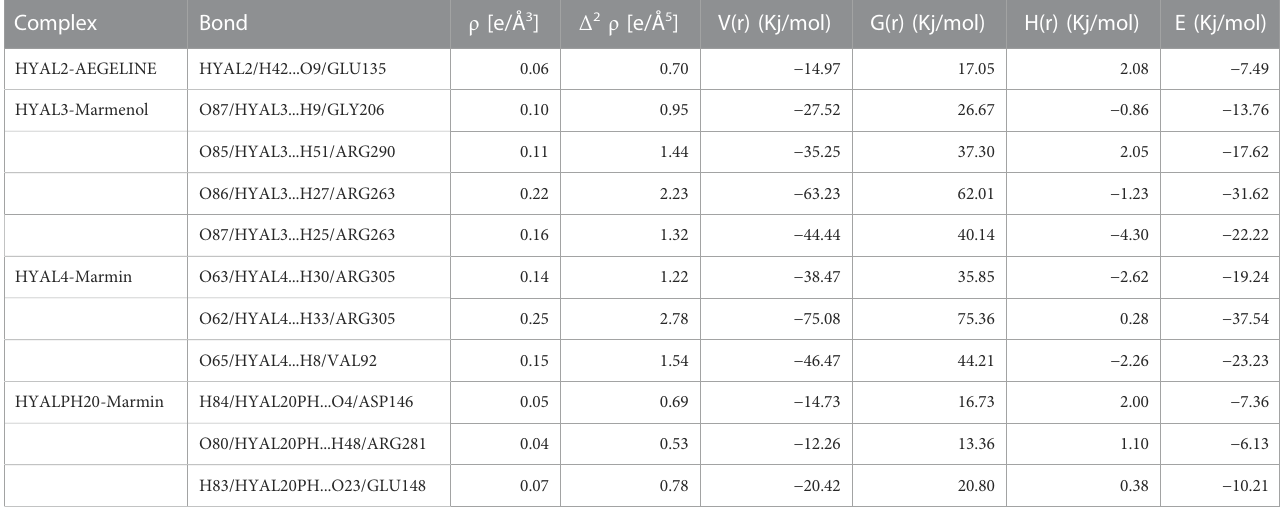
TABLE 6 Bond topological parameters of H-bond interactions calculated at bcp of complexes. Complex